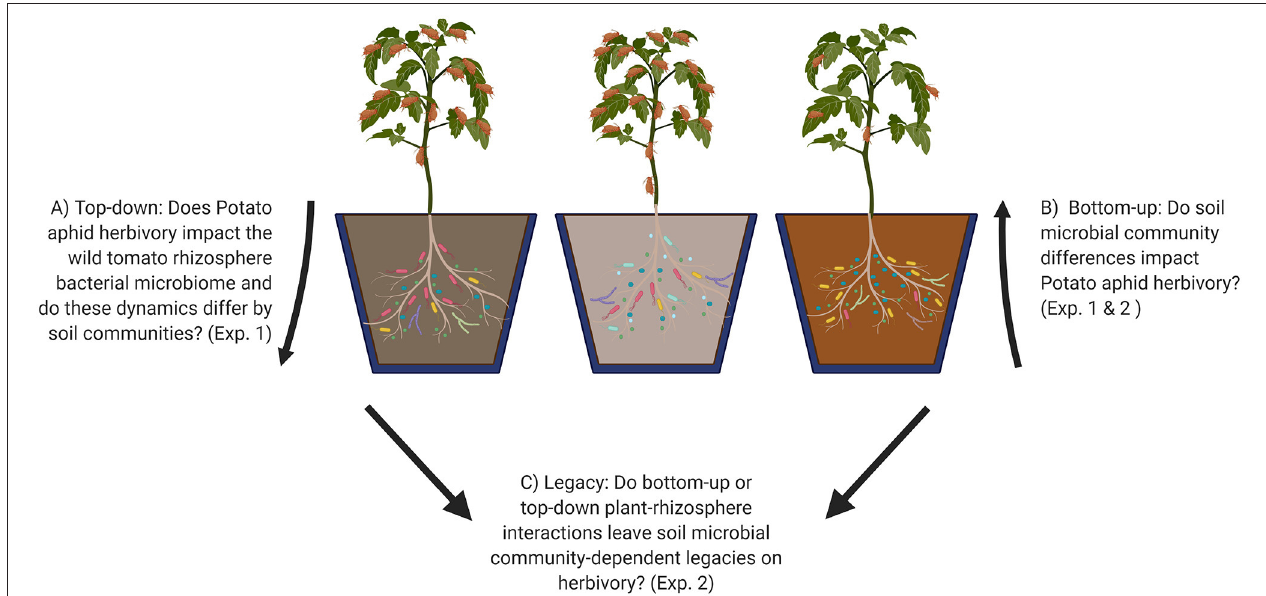
FIGURE 1 | Graphical representation of experimental questions (A–C) addressed in this study. Numbers in parentheses refer to the experiments that address each question. Experiment 1: Top-down and bottom-up effects of aphid-tomato-microbiome interactions. Experiment 2: Soil microbial legacy effects of aphid infestation. Made in